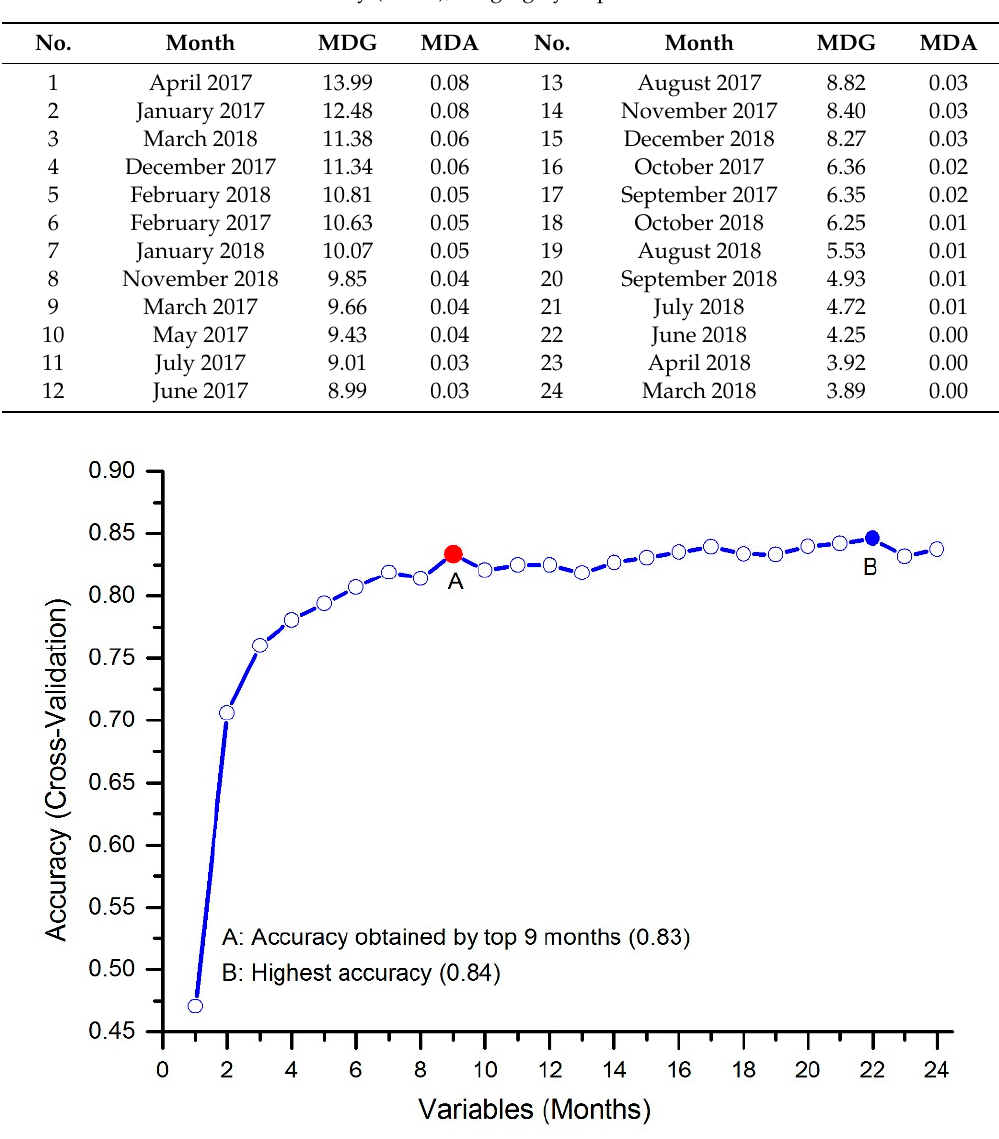
Figure 8. E ff ect of the number of months on the cross-validation